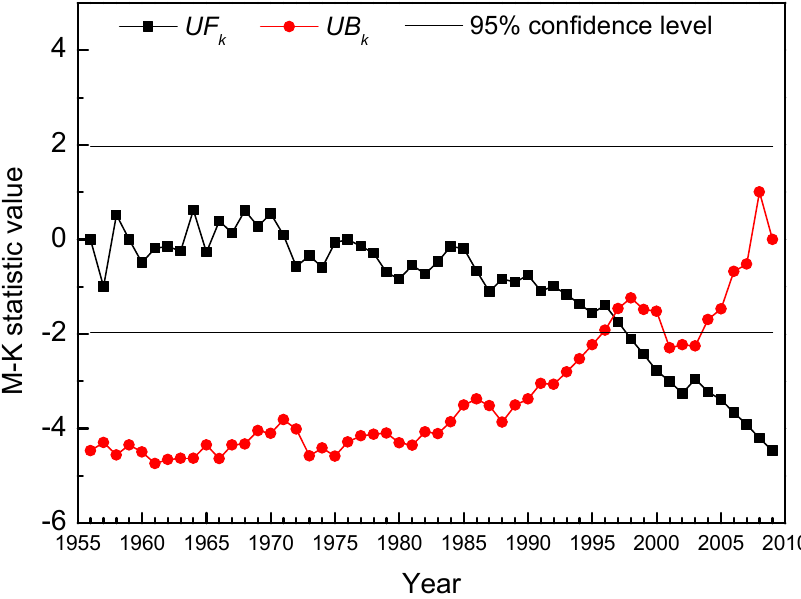
Figure 3. Statistical test for abrupt changes in annual streamflow (There is an intersection point of the UF and UB lines after year 1996, suggesting an abrupt point).